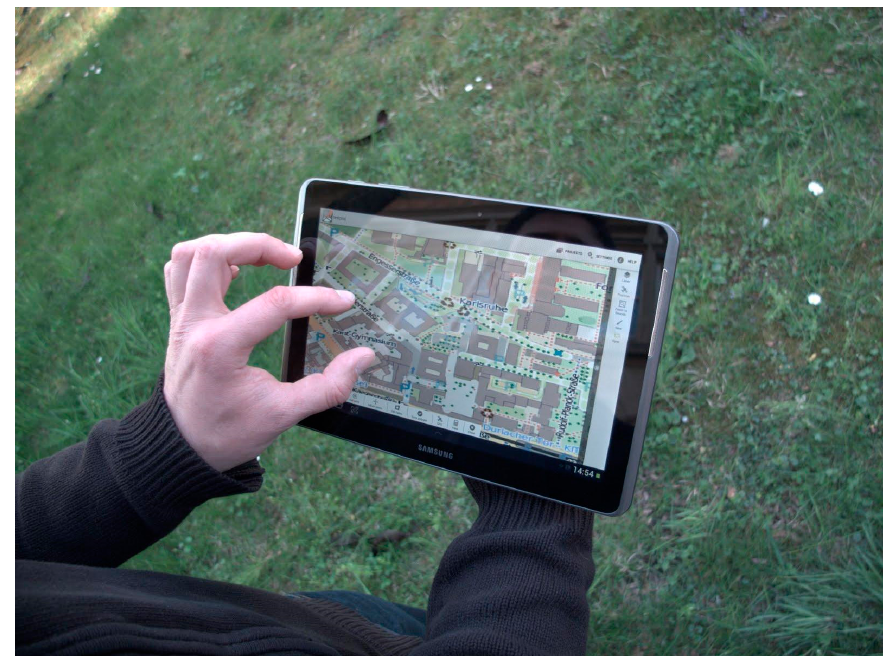
Figure 8. Survey study with GeoTechMobile at the State Agency for Spatial Information and Rural Development Baden-Württemberg (LGL, branch Karlsruhe).